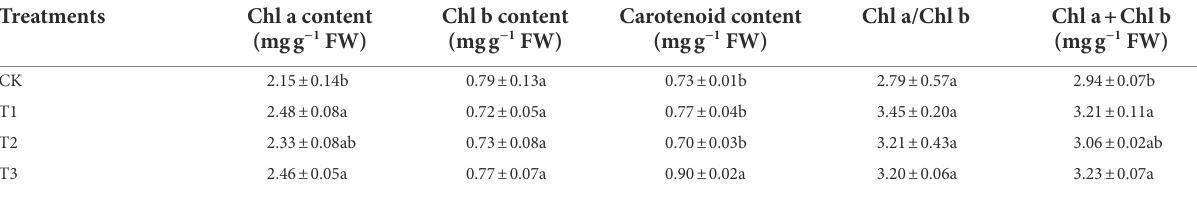
TABLE 2 Effects of different irrigation amounts on photosynthetic pigments content in leaves of eggplants.